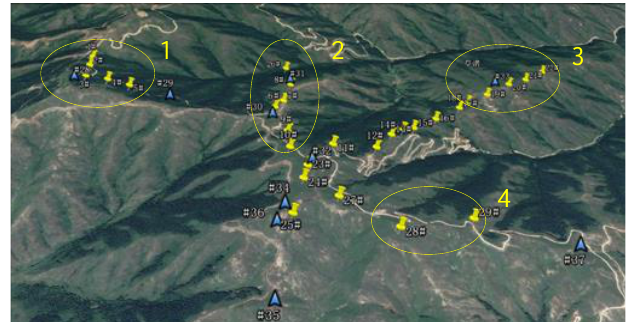
Figure 3. Geographical distribution map of wind turbines.